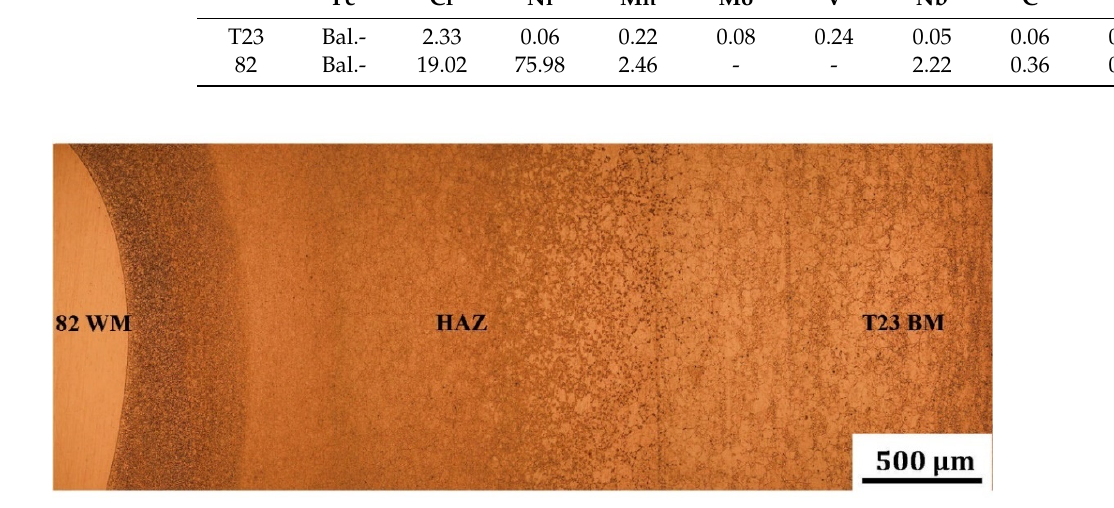
Figure 2. Microscopic image of weld overlay joint.